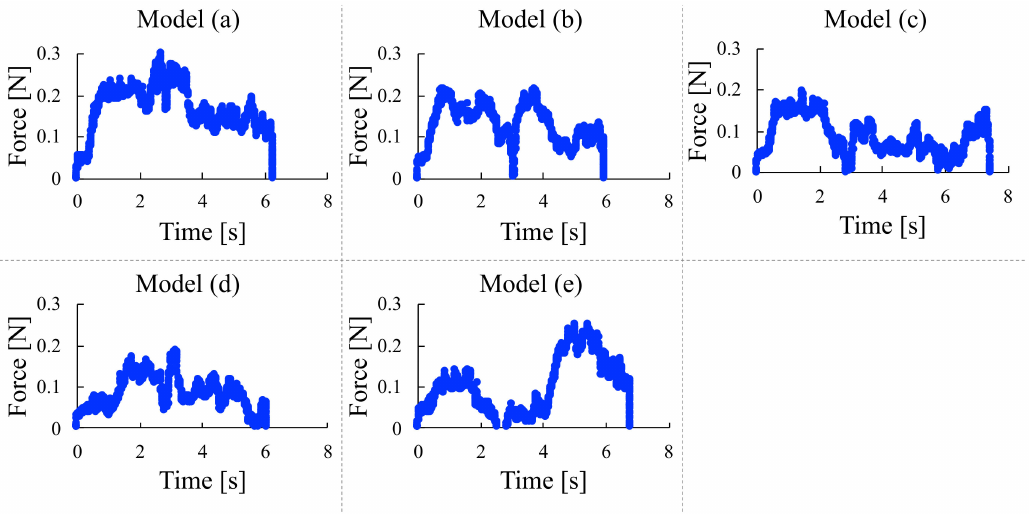
Figure 12. Experimental results of the microscissors tests in each dura-mater model ( a – e